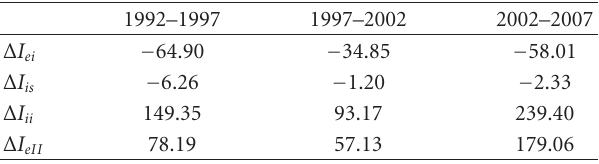
Table 1: The structural decomposition results of China’s embodied energy use in infrastructure